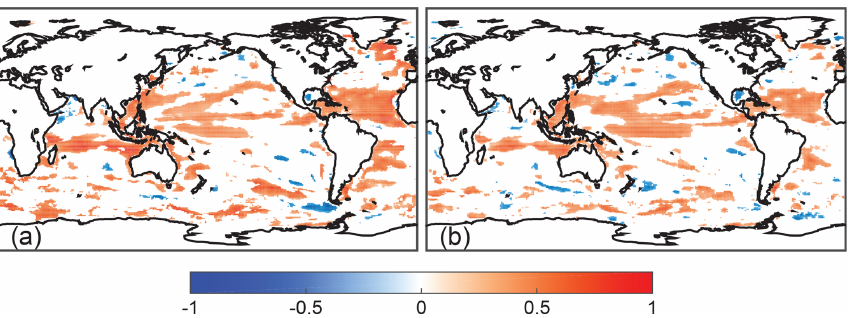
Figure 7. Air–sea CO 2 flux predictive skill, as indicated by the correlation coefficient of air–sea CO 2 flux (a) anomalies, and (b) linearly detrended anomalies from the CESM-DPLE initialized forecast in year 1 with the Landschützer et al. (2016) observational product over 1995– 2015. Correlation coefficients that are not statistically significant at the 95% level using a t test are assigned a value of